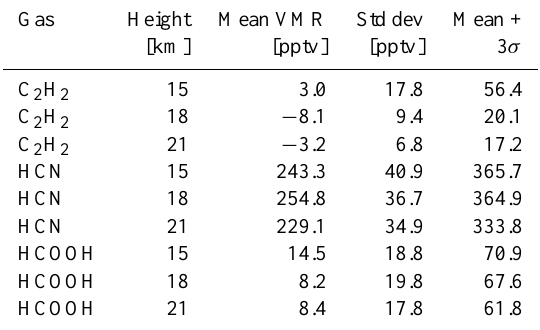
Table 1. Mean values, scatter and upper thresholds for outliers of southern hemispheric C 2 H 2 , HCN, and HCOOH measured by MI- PAS during background conditions, averaged over the period 1 Jan- uary to 7 February